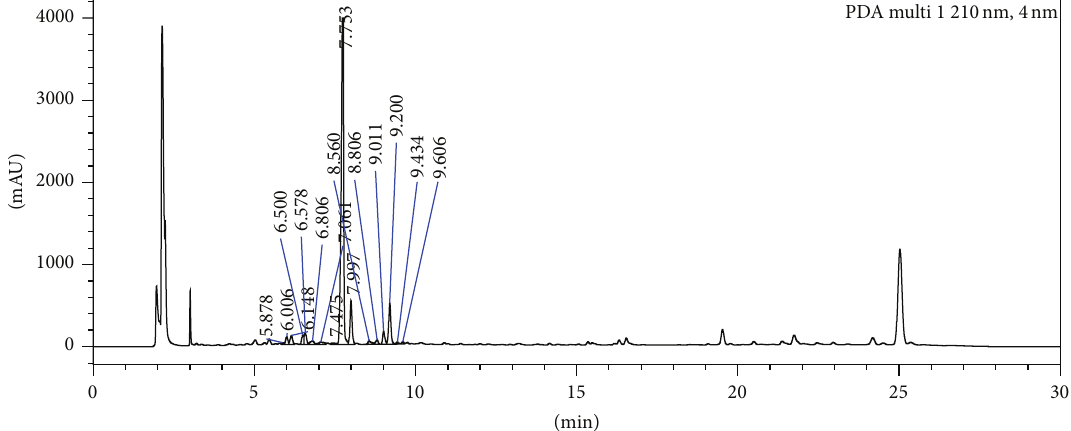
Figure 1: HPLC chromatogram (210nm) of the A. belladonna methanolic extract showing peaks of atropine and scopolamine.